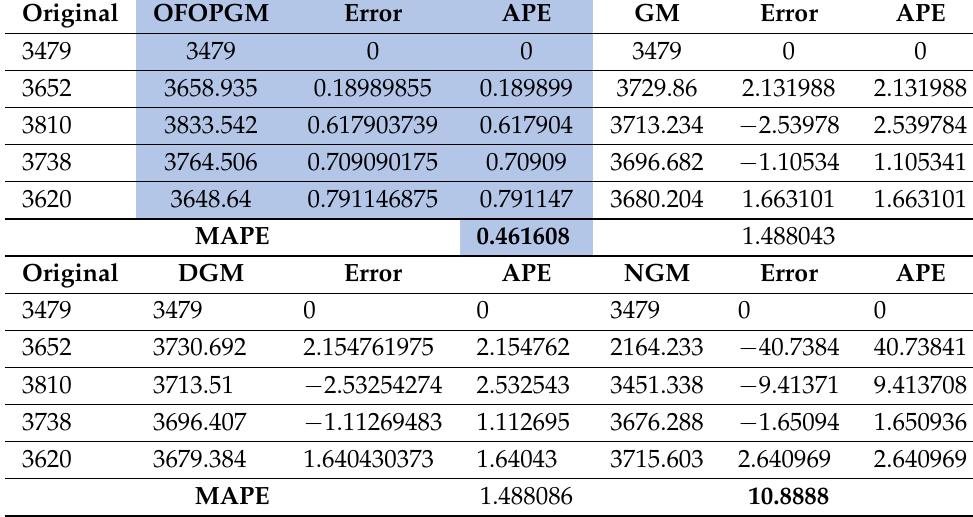
Table 4. Energy consumption forecast